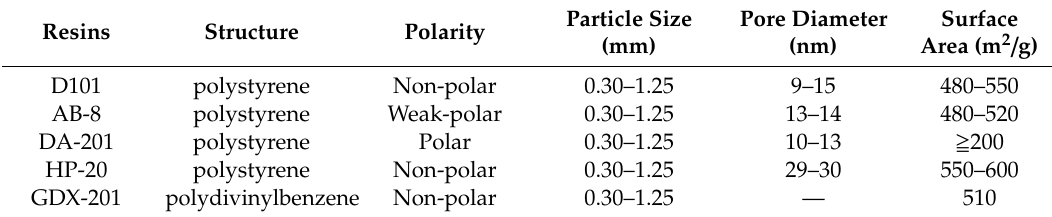
Figure 2. Adsorption, desorption capacities and desorption ratio of the total of three coumarins. Table 1. Physical properties of five macroporous